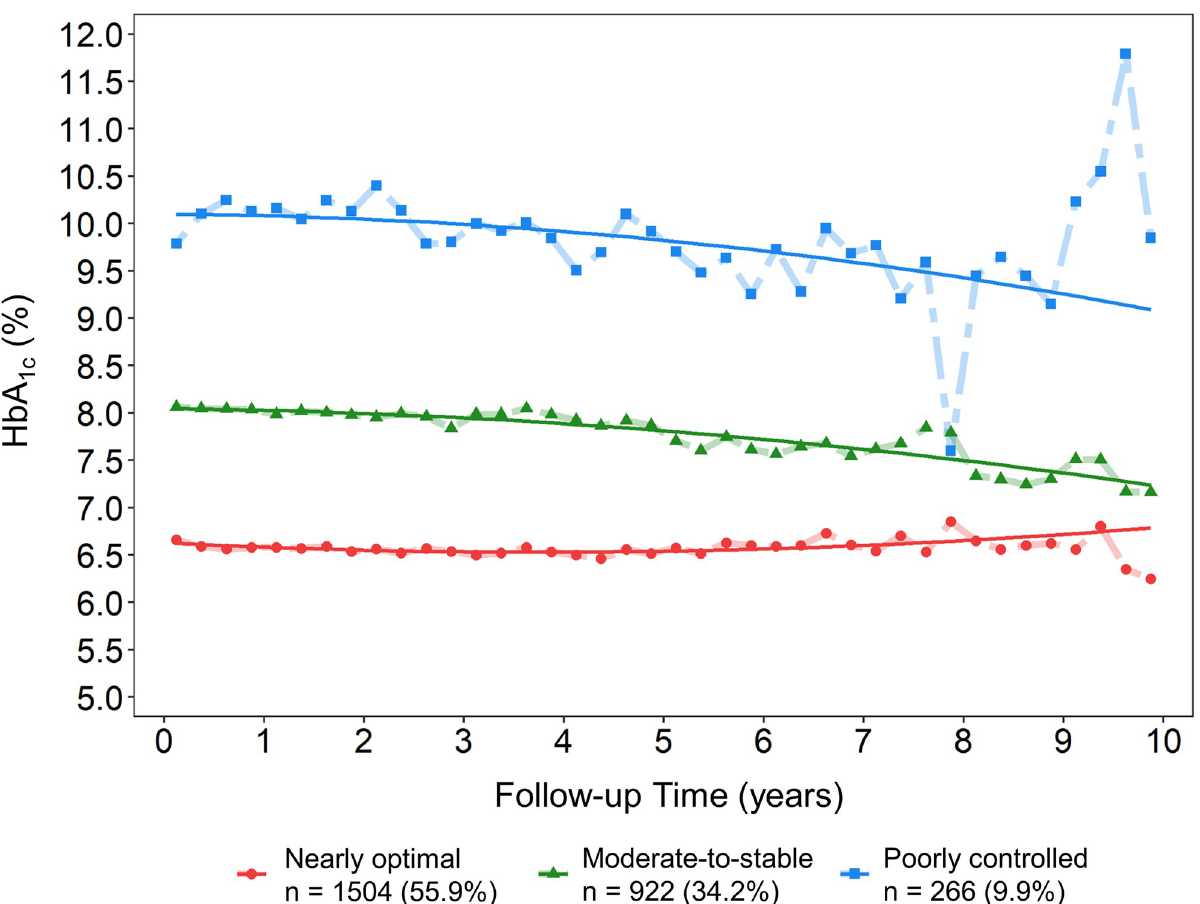
Fig 2. HbA 1c trajectories by group-based trajectory modeling as per the three-trajectory solution. The solid lines indicate the mean estimated trajectories; the points represent the mean observed trajectories.